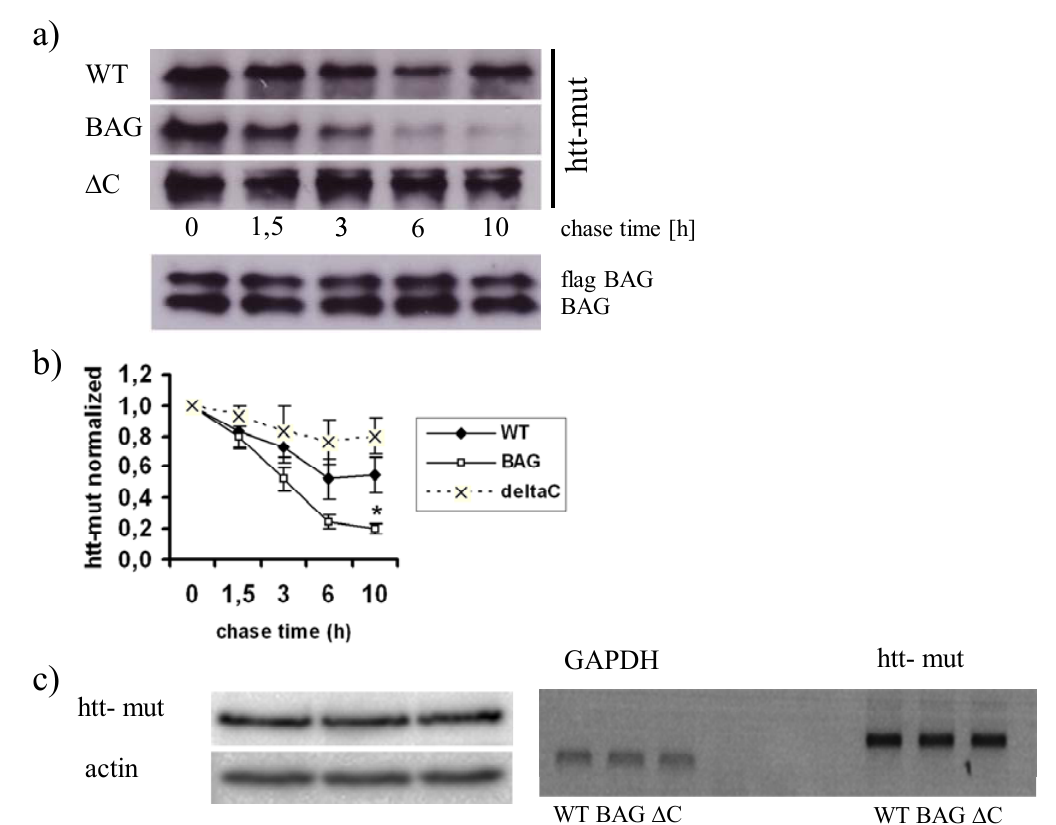
Figure 3. BAG Δ C does not enhance htt-mut